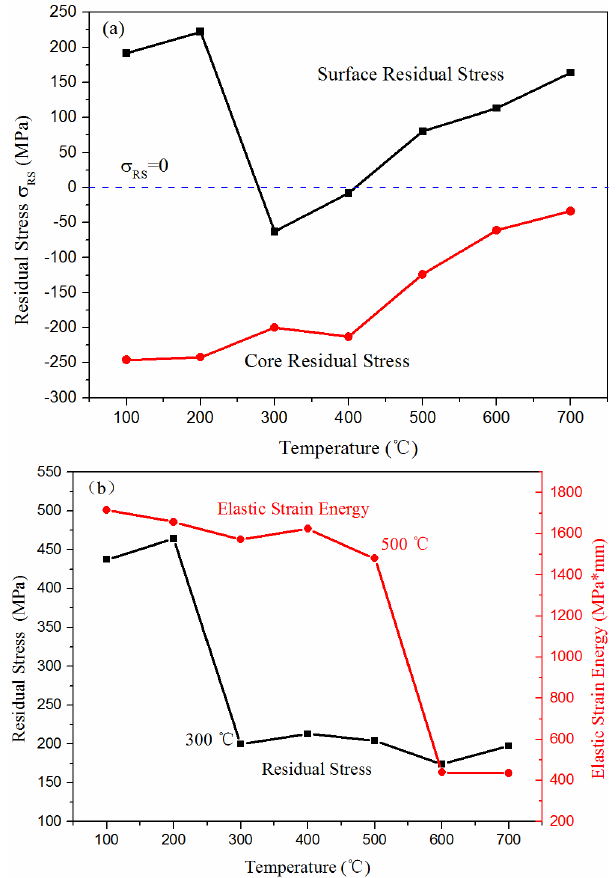
Figure 8. Evolution of residual stress during tempering. ( a ) Evolution of residual stress on the surface and in the core; ( b ) Evolution of residual stress and elastic strain energy along the thickness direction.